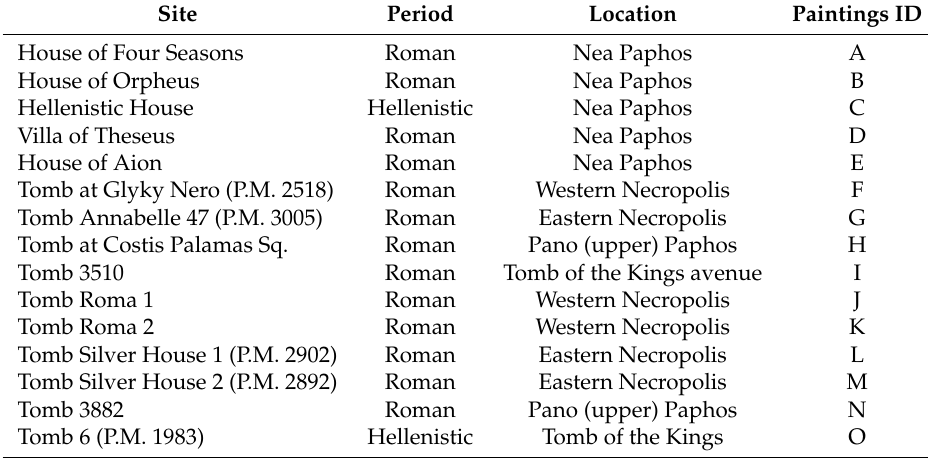
Table 1. A list of the sites with wall paintings analyzed and their location. A painting ID (letter) is assigned for reference in the Results and Discussion section where the pigments are discussed. Numbers following the ID letter refer to a specific location, painting or collection of fragments from the site.